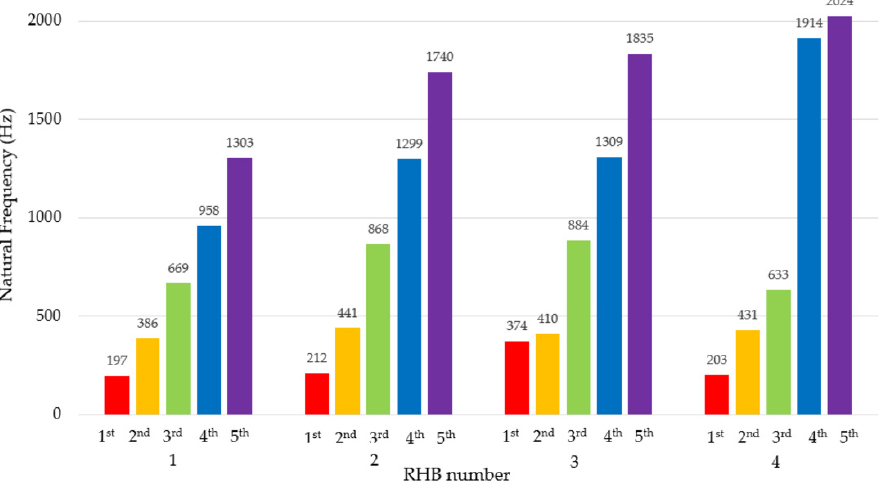
Figure 4. Natural frequencies (1st–5th) and vertical, horizontal, and axial directions of impacts in the bump test (up).